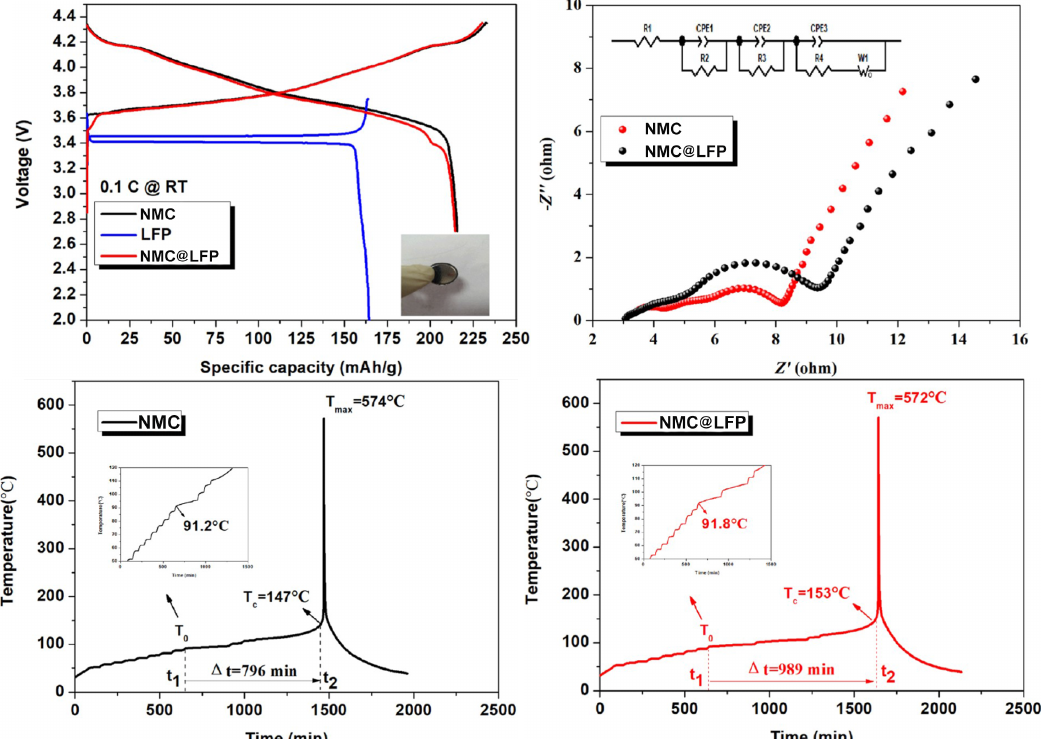
Figure 11. ( Top ) Charge/discharge curves for NMC, LFP, and NMC@LFP composite cathodes; Nyquist plots for NMC and NMC@LFP cathodes; ( Bottom ) Thermal runaway curves for full cells ( left ) NMC || Graphite and ( right ) NMC@LFP || Graphite. Reproduced with permission